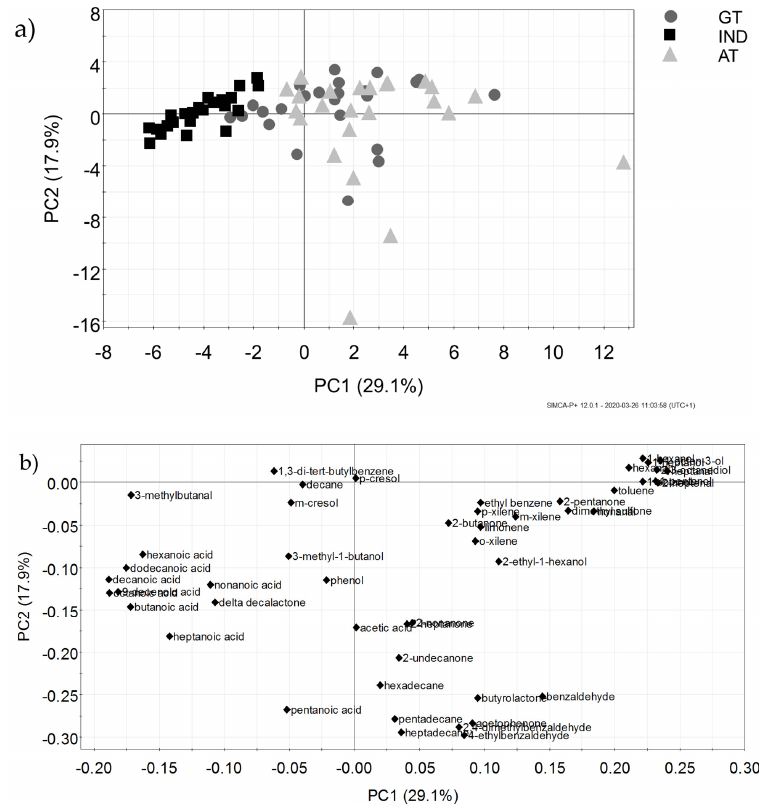
Figure 1. Principal component analysis of volatile organic compounds (VOCs) showing experimental groups’ milks ( a ); GT = dairy cows adapted to fresh herbage feeding before grazing; AT = dairy cows not adapted to fresh herbage feeding before grazing; IND = dairy cows kept in a cubicle system) and individual VOCs ( b ).